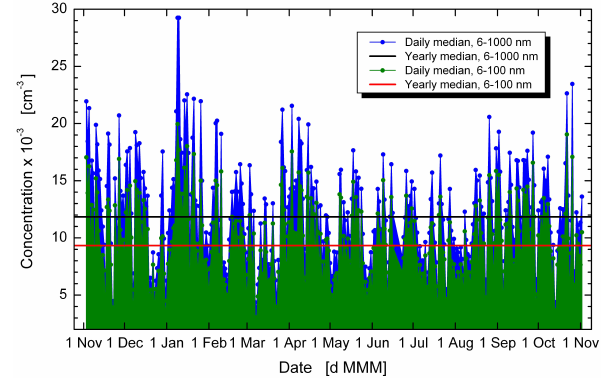
Fig. 2. Median particle number concentrations in the diameter ranges from 6 to 1000nm and from 6 to 100nm near central Bu- dapest from 3 November 2008 to 2 November